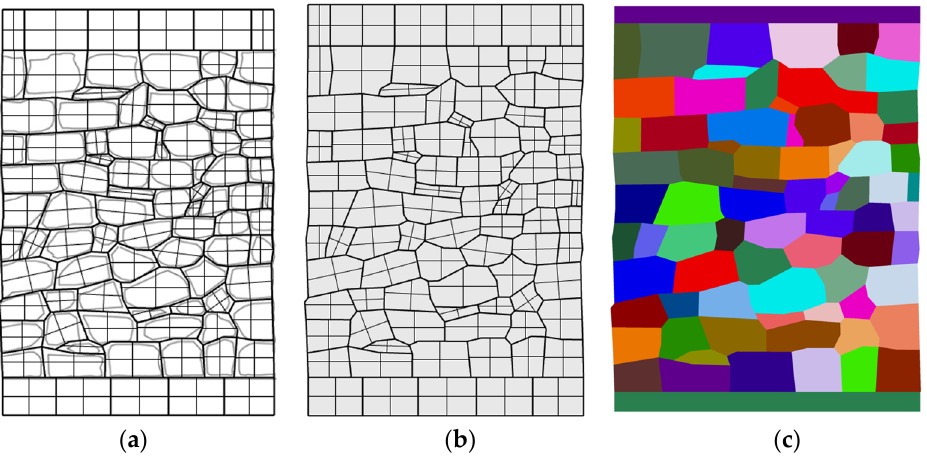
Figure 3. Representation of benchmark study ( a ) traced in Rhino6, ( b ) solid model in Rhino6, and ( c ) discrete element model (3DEC). Table 1. Contact properties defined in the discrete element model.